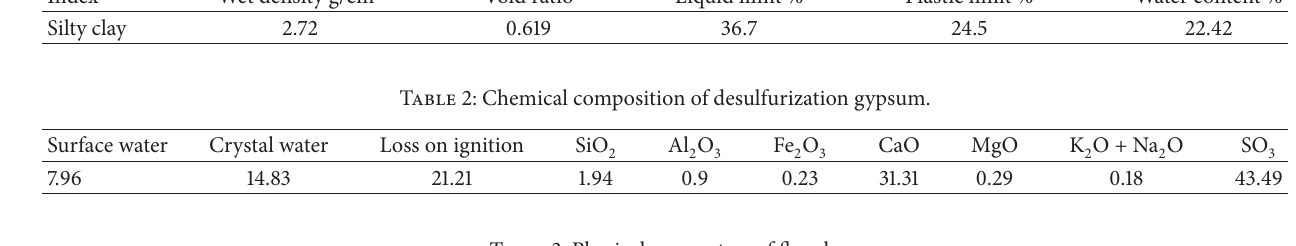
Table 3: Physical parameters of fly ash.